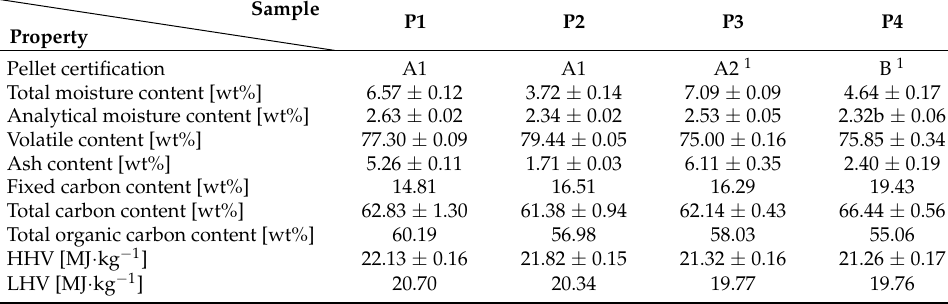
Table 2. Properties of the tested pellets (as received).